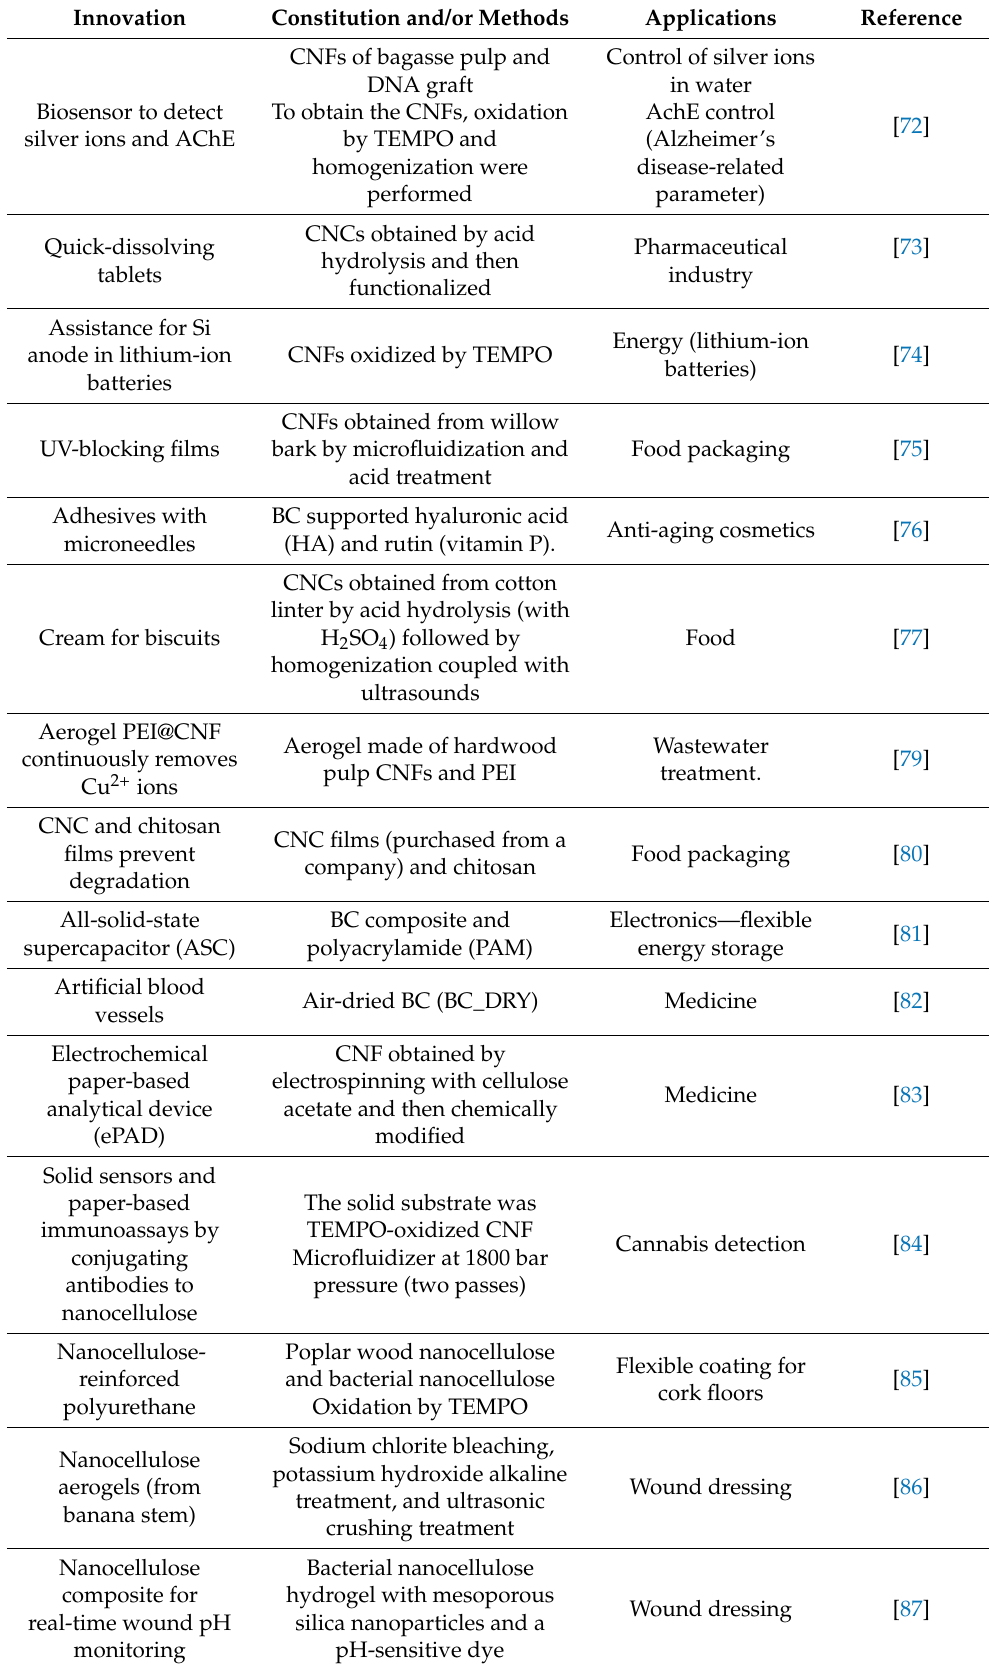
Table 7. Some applications of nanocelluloses (published from 2021 to